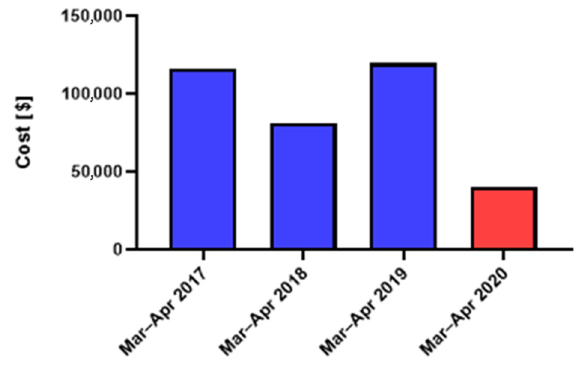
Figure 7. Total costs associated with maxillofacial fractures in the patients admitted during the COVID era and the corresponding periods in